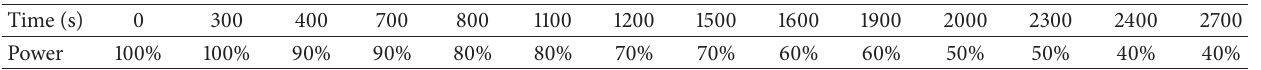
Table 2: Time sheet for power change in transient